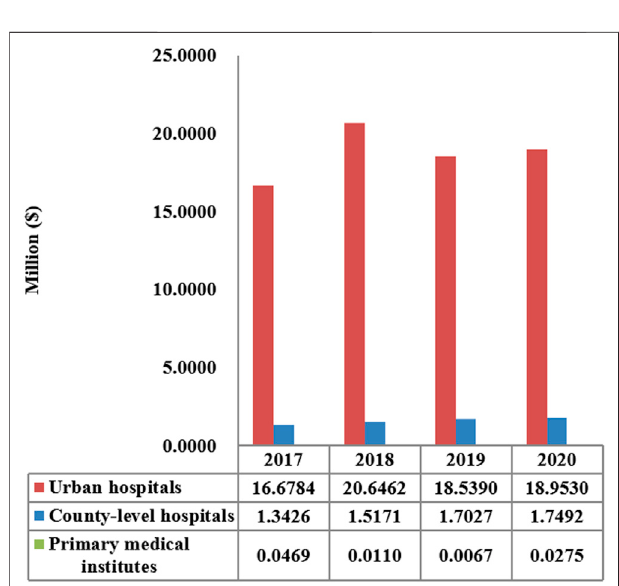
FIGURE 2 | Total carbapenem expenditure by the level of healthcare institution in Shaanxi Province, 2017 – 2020.